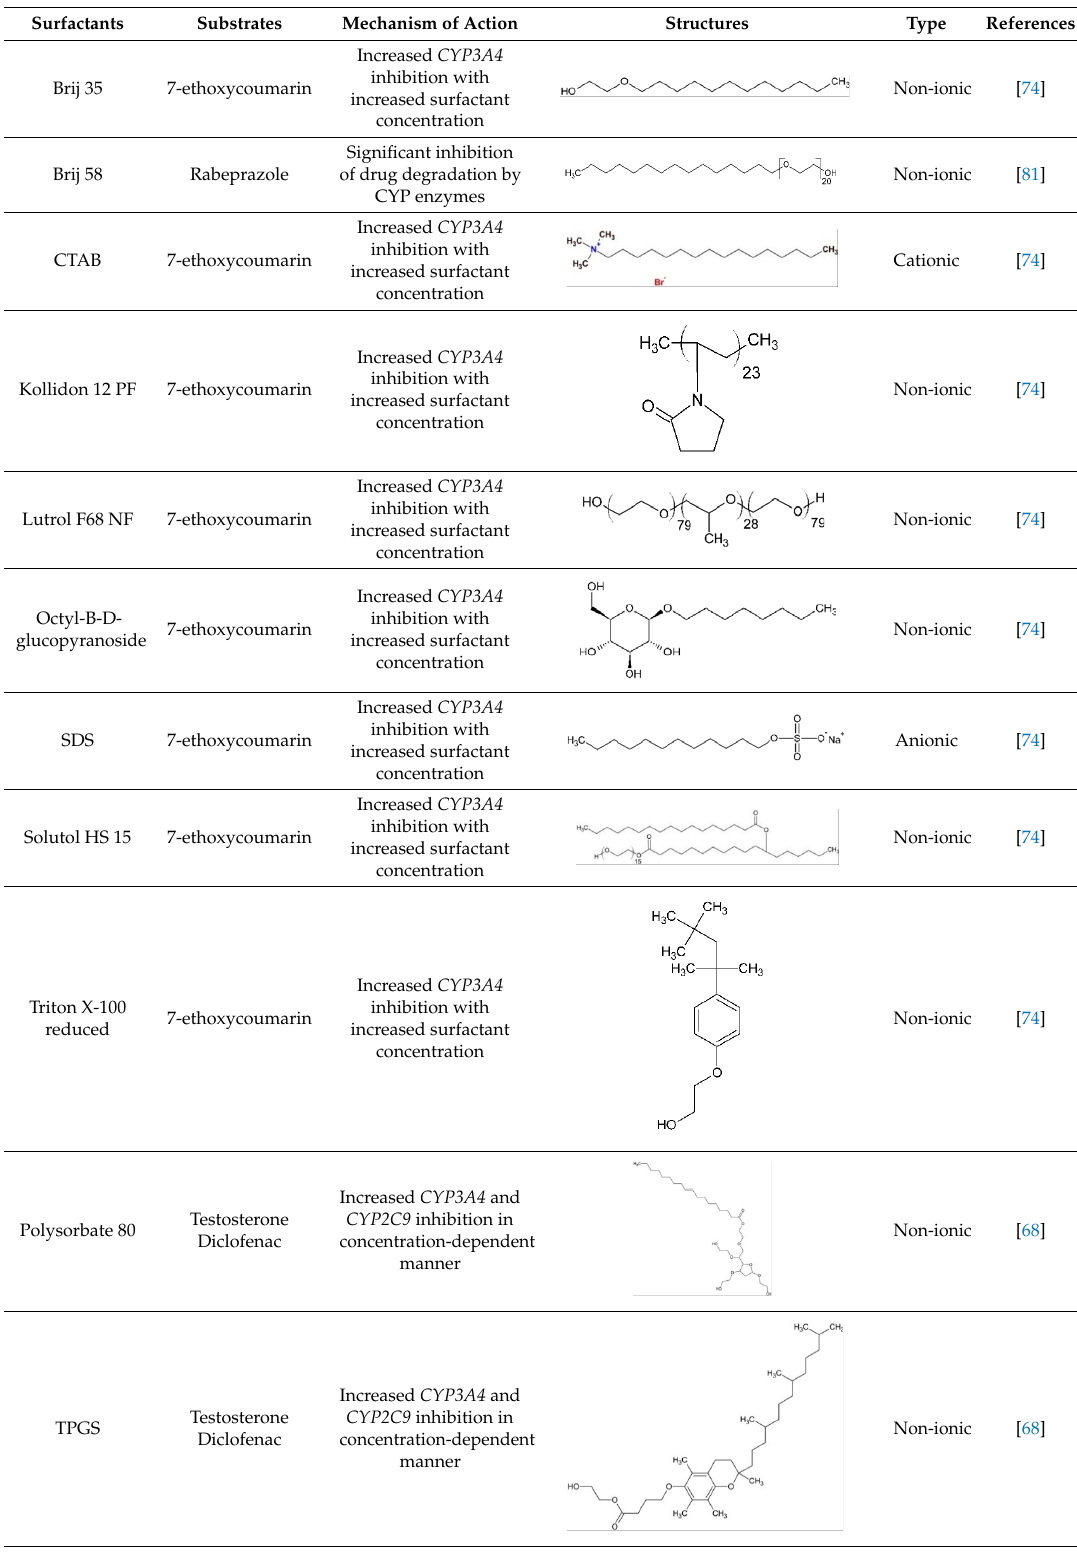
Table 2. Summary of the e ff ect of surfactants on CYP